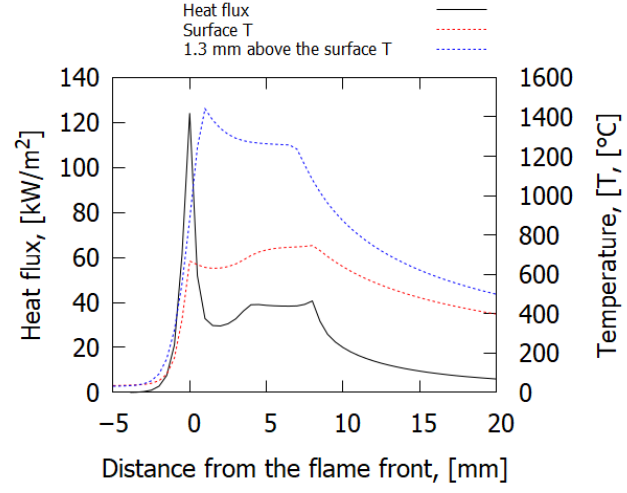
Figure 9. The calculated temperature profiles in the condensed and in the gas phase (at a height of 1.3 mm above the surface) and the heat flux profile for a 0.3 mm- thick sample at 25% О 2 .